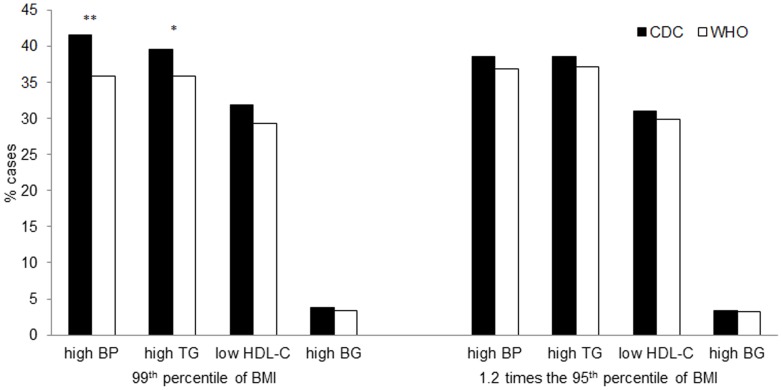
Relative frequency of single cardiometabolic risk factors in children with severe obesity defined according to BMI-for-age ≥99th percentile or ≥1.2 times the 95th percentile, by CDC or WHO.